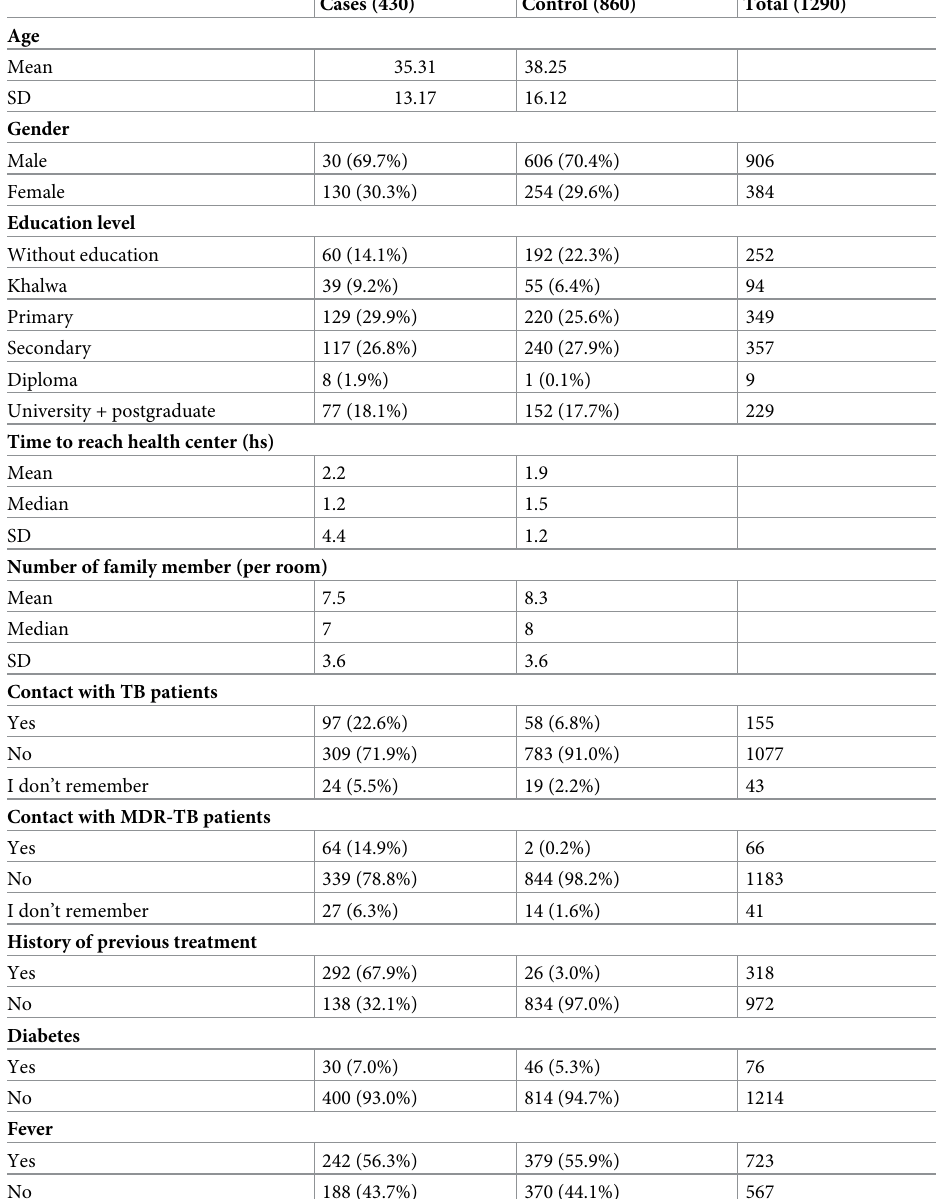
Table 1. Demographic and clinical characteristics of stud